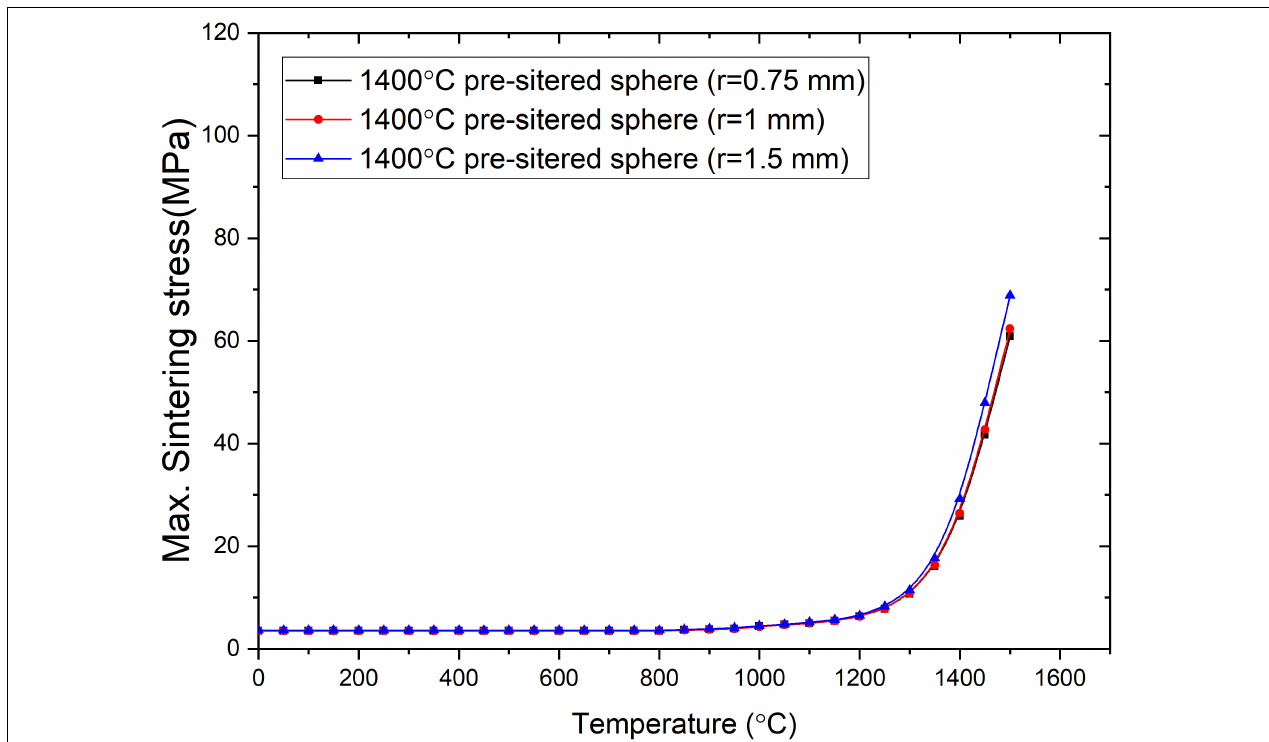
FIGURE 8 | FEA-calculated maximum sintering stress in YSZ oxide pellets containing lumped Gd 2 O 3 spheres of different sizes but equal shrinkage rates.